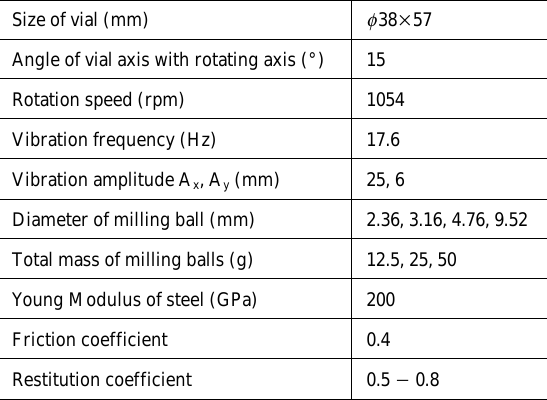
Table 1 Input parameters of